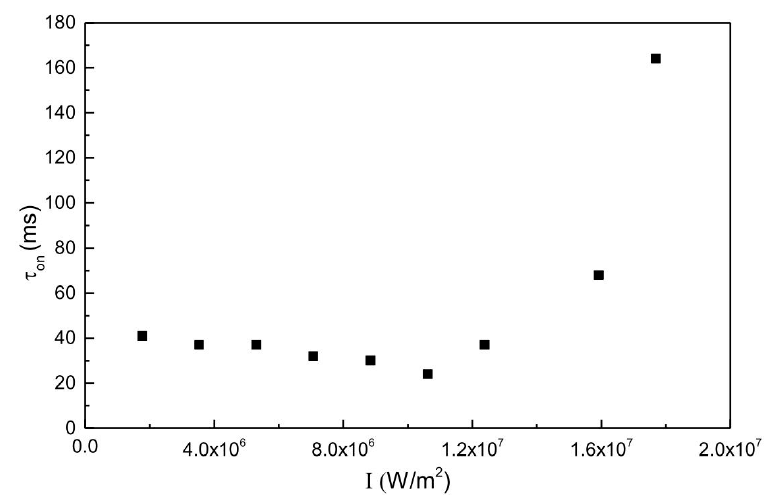
Figure 7. Rise time τ on as evaluated from exponential fits of the raw data as a function of the pump light intensity. A change of the dependence on I is observed for values of light intensity higher than 1.1 × 10 7 W/m 2